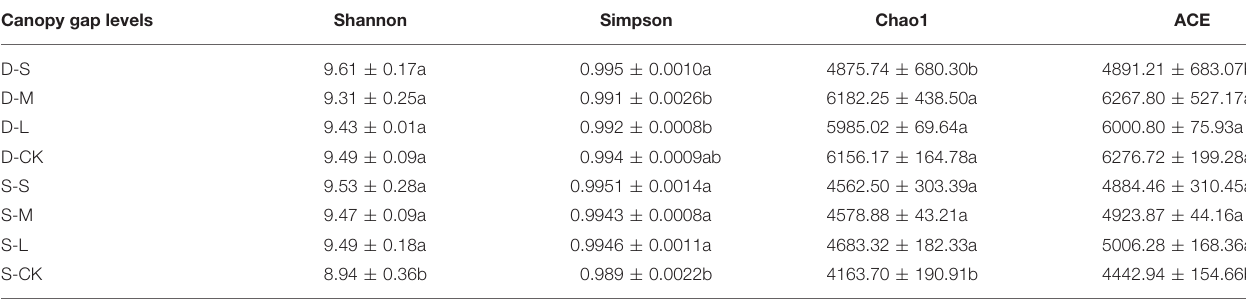
TABLE 3 | Changes in soil bacterial alpha diversity among forest gap sizes. Canopy gap levels